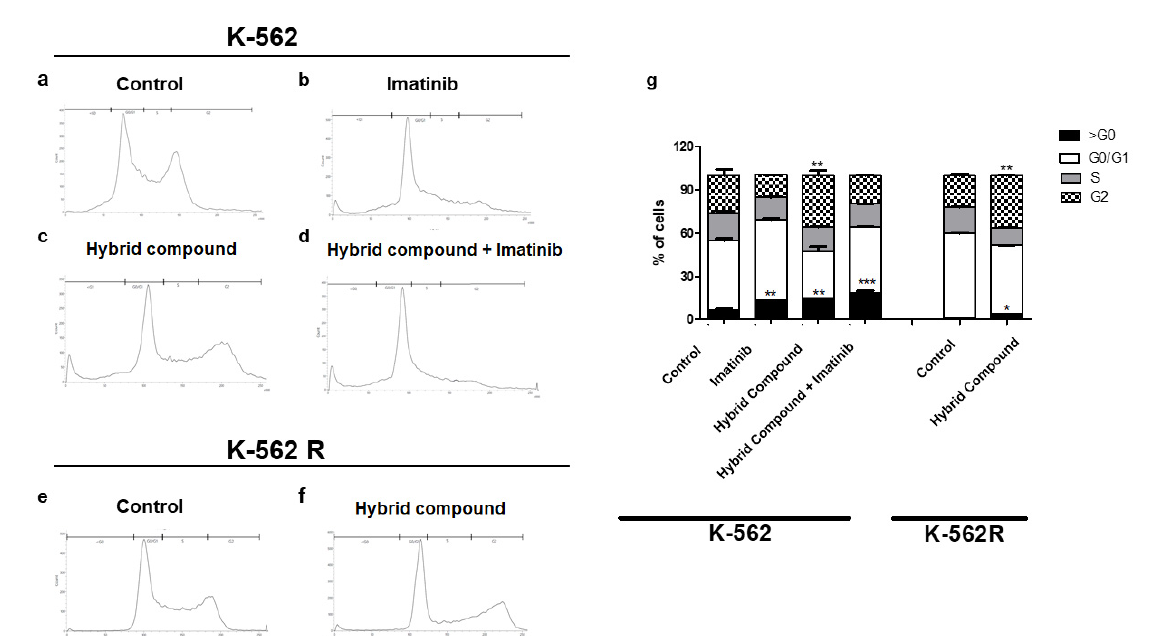
Figure 6. Cell cycle distribution after 48 h of treatment of K-562 cells with ( a ) only RPMI-1640 medium, ( b ) imatinib, ( c ) hybrid compound and ( d ) or combination of hybrid compound and imatinib, and of K-562R cells with ( e ) only RPMI 1640 medium or ( f ) hybrid compound ( g ) Percentage of sub- G0, G0/G1, S and G2 are shown. Data are reported as mean ± standard deviation (SD) of three ex-